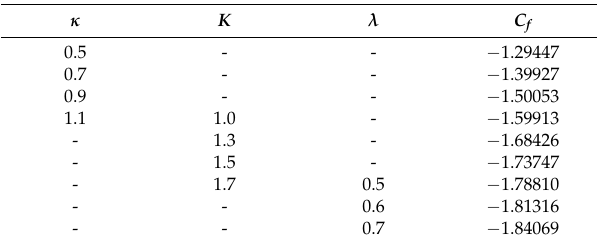
Ψ ( F (cid:48)(cid:48) ( 0 )) , when A = 0.5, Ψ = 1 at 3